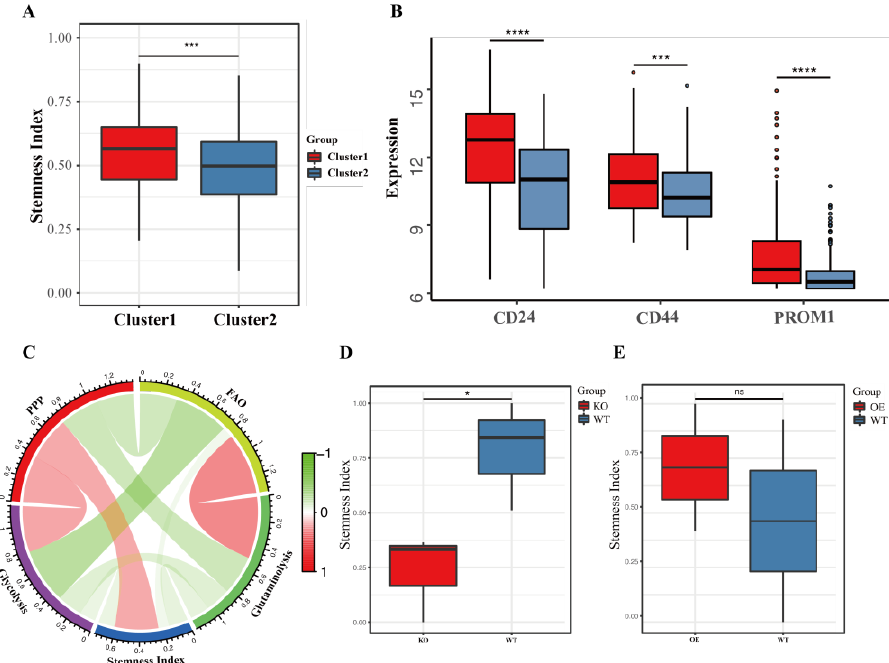
Figure 4. PPP activity regulates the stemness of cancer cells. ( A ) Quantification of the stemness index for two clusters. ( B ) Relative expression of stemness-associated genes. ( C ) A chord diagram displaying the correlation between four energy metabolic pathway activities and liver cancer stemness. ( D , E ) Comparison of tumor cell stemness indices after knockout ( D ) or overexpression ( E ). KO, knockout; OE, overexpression. ns, p value > 0.05; *, p value < 0.05; ***, p value < 0.001; ****, p value < 0.0001.